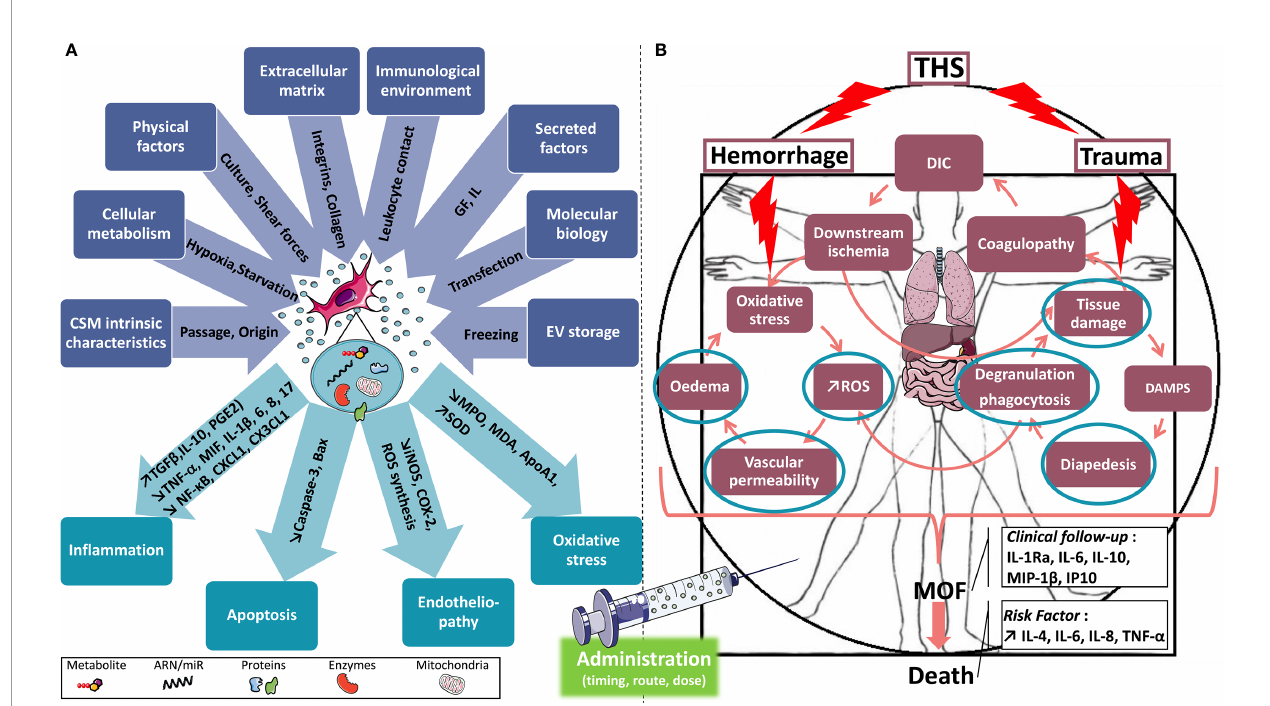
FIGURE 4 | MSC-EVs in THS, or how to apply recent knowledge at the service of those seriously injured. (A) In blue are the main factors modulating the production of EVs. EVs in the center contain, depending on the priming, organelles, proteins, enzymes, RNA, and miR in variable quantities. In aquamarine are the possible main pathways of the potential bene fi cial effects of EVs in THS models. The administration methods vary by model and must be explored. (B) Simpli fi ed consequences of THS. Three loops (coagulopathy, in fl ammation, and endotheliopathy) are involved in the vicious circle leading to MOF. Cytokines of clinical interest are predictors of the onset of MOF. IL-4, IL-6, IL-8, and TNF- a are signi fi cantly increased in trauma patients with MOF and not surviving it. Items circled in aquamarine are potential targets for EV action. EVs, extracellular vesicles; MSC-EVs, mesenchymal stromal cell-derived extracellular vesicles; THS, traumatic hemorrhagic shock; MOF, multi- organ failure; MPO, myeloperoxidase; MDA, malondialdehyde; SOD, superoxide dismutase; GF, growth factor; IL,